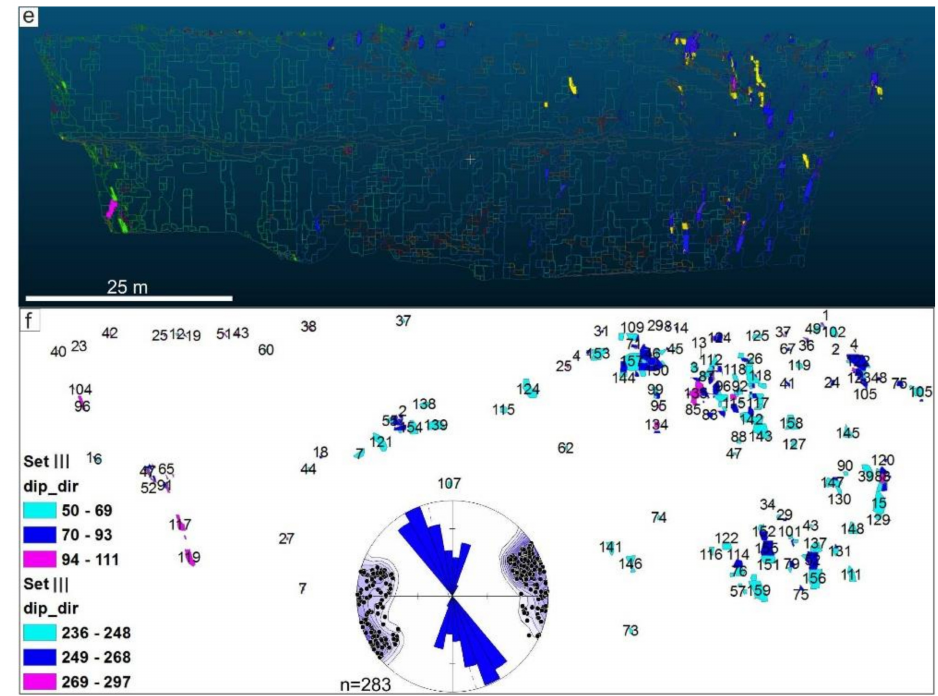
Figure 7. Fracture planes and their orientations extracted using the ‘Facet’ plugin with an angular step at 5 ◦ . Different colors represent dip direction in all sub figures. Results were further analyzed in ArcMap to categorize dip directions. ( a ) Fracture set I and ( b ) ArcMap analysis showing facets in two distinct colors based on dip direction. ‘Facet’ data is plotted in a rose diagram and associated poles of fracture planes. The dominant strike of the fractures is NW-SE. ( c ) ‘Facet’ analysis of fracture set II trending NE-SW and ( d ) corresponding ArcMap plot. ( e ) Orientation of fracture set III calculated using ‘Facets’ and ( f ) ArcMap analysis. See text for further explanation. Colors palettes refer to dip directions in ( d , f